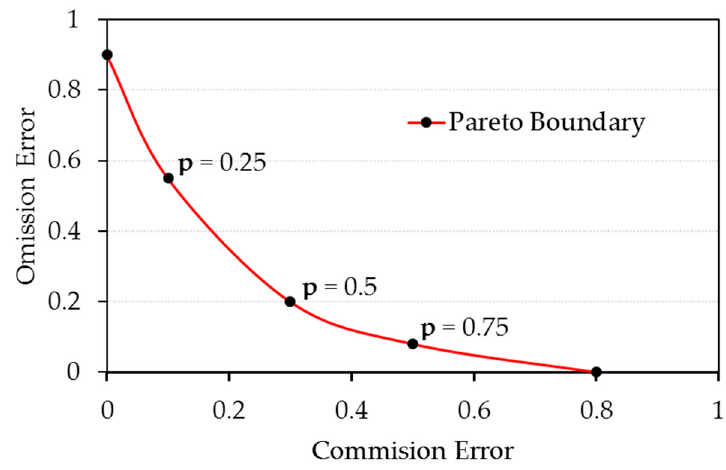
Figure 6. Pareto boundary for a binary classification (Burned / Non-Burned). p represents the minimum percentage of burned area to classify a mixed pixel as Burned.